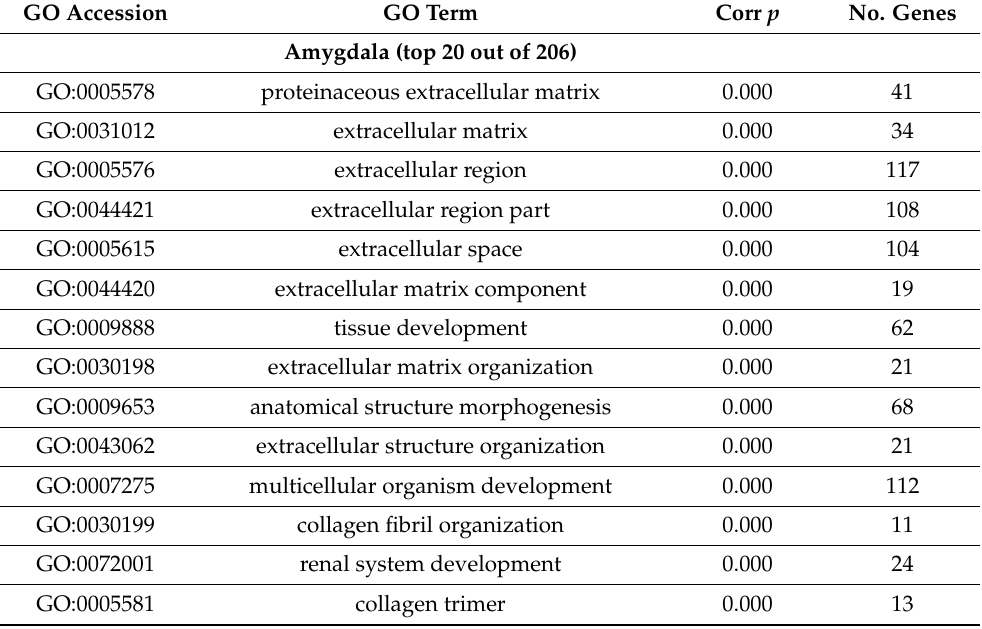
Table 4. Differentially expressed genes enriched in GO terms in stress-exposed rats after two weeks of lithium